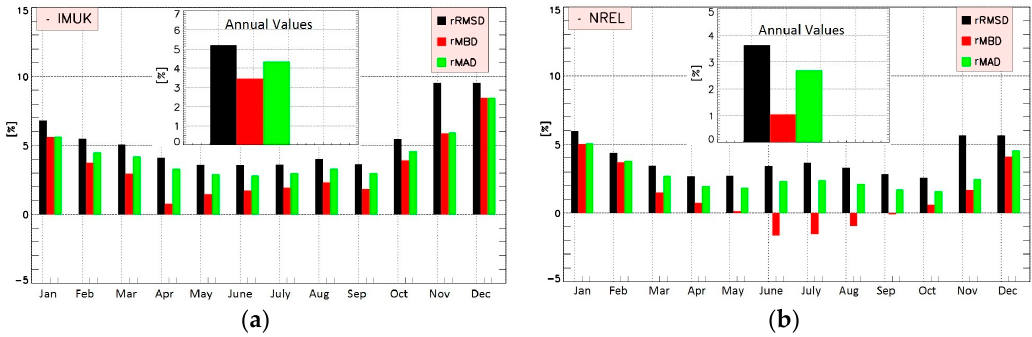
Figure 4. Monthly and annual average of the statistical indices relative Root Mean Square Difference (rRMSD), relative Mean Absolute Difference (rMBD) and relative Mean Bias Difference (rMAD) between pyranometer and silicon sensor measurements at IMUK ( a ) and at NREL ( b ). The statistical indices show clear differences in the magnitude and show a seasonal dependence.